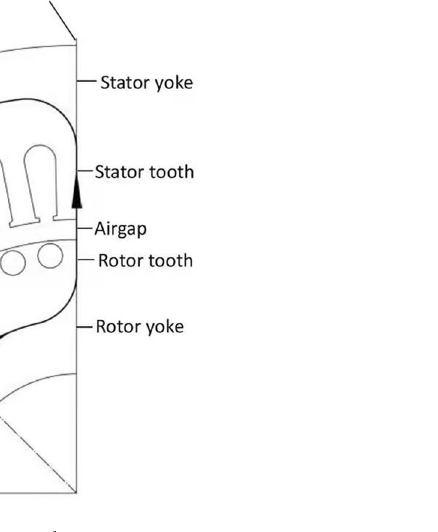
Figure 1. Typical magnetic circuit of IMs per